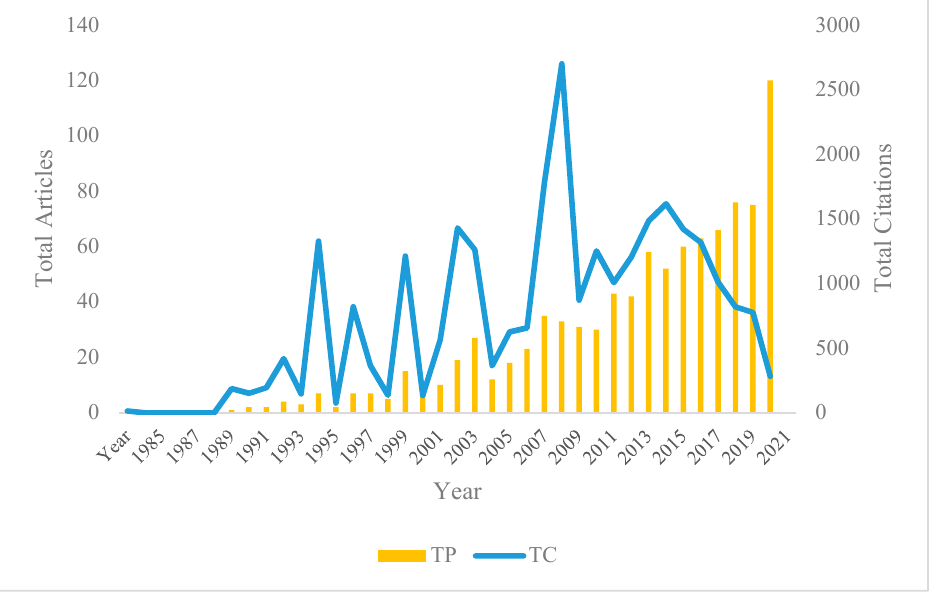
Figure 2. Growth of publication by year.